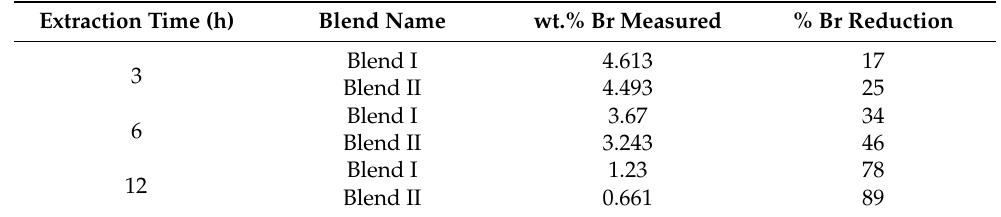
Table 1. Bromine content after using isopropanol as solvent and applying different extraction times. Extraction Time